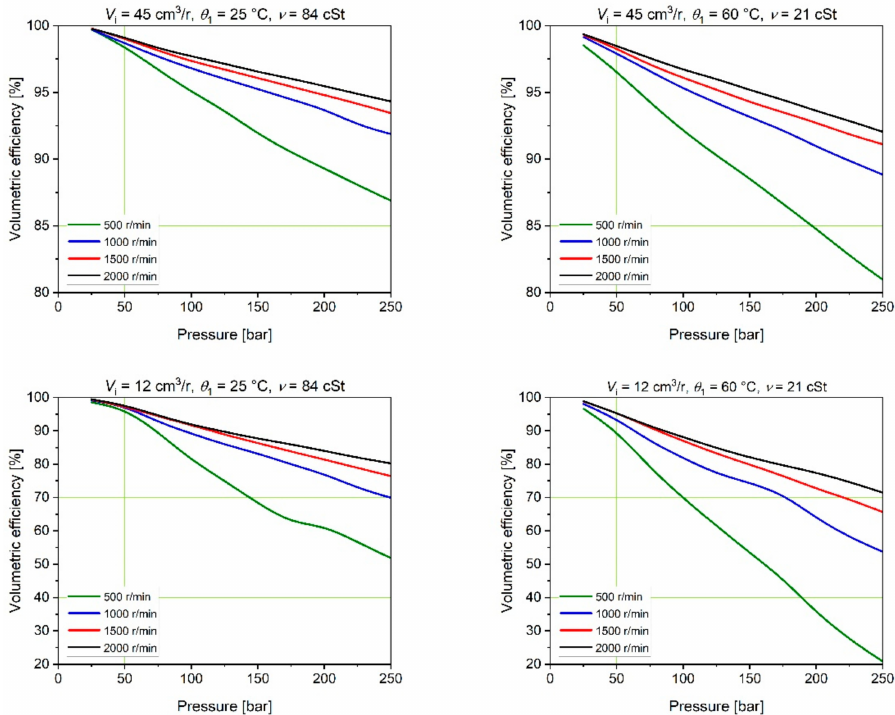
Figure 8. Volumetric efficiency of an axial piston pump as a function of pressure with four constant rotational speeds. The ten-calculation-point efficiency curves have been smoothed with B-splines. Note the varying efficiency scales.